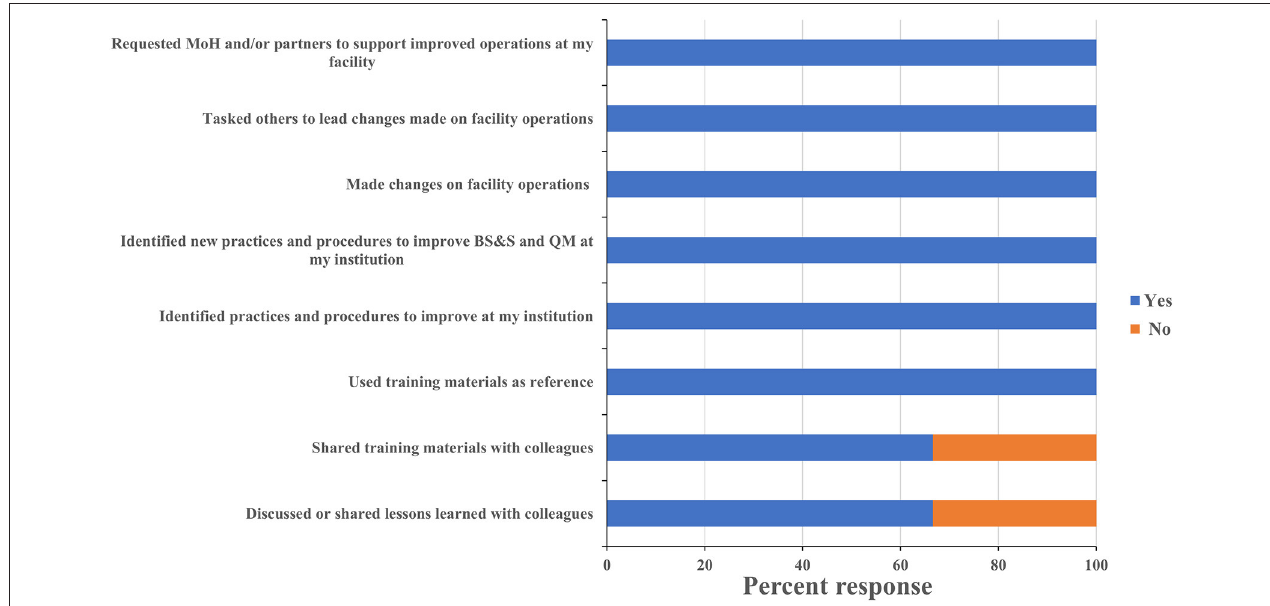
FIGURE 5 | Leadership training sustainability. Questionnaires were designed to assess the sustainability of the lessons learnt and skills gained on leadership participant’s professional activities at their institution. Trainees were asked to respond “yes” or “no” to each question and the percentage of respondents selecting each answer was calculated. MoH, ministry of health; BS&S, biosafety and biosecurity; QM, quality management.